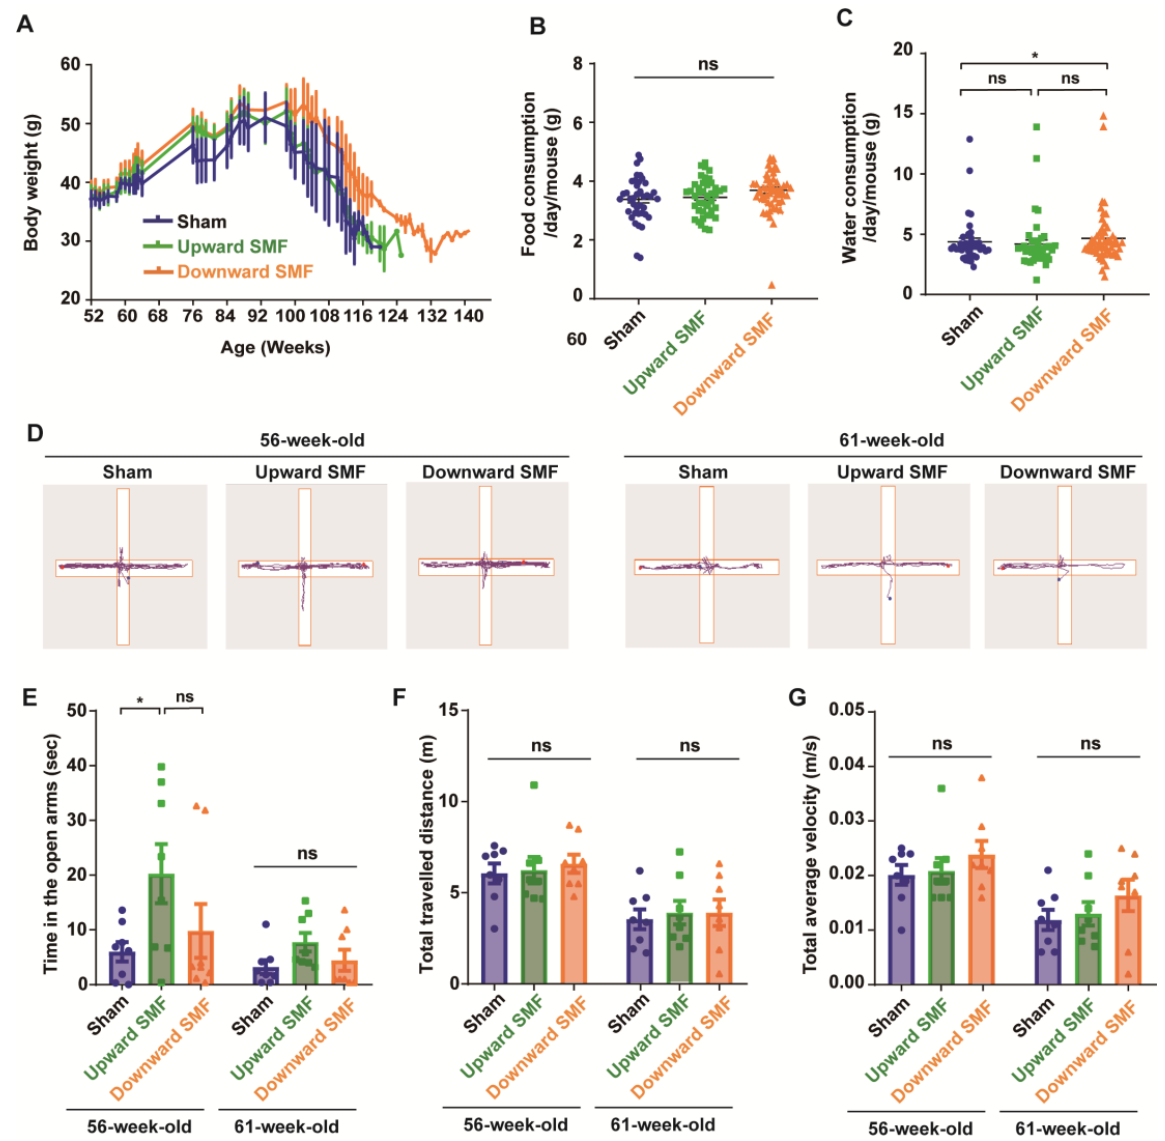
Figure 2. Elevated plus maze test shows that SMFs could improve the exploration activity of aged mice. ( A ) The mice body weight changes; ( B ) food consumption; ( C ) water consumption; ( D ) representative trajectories of mice in elevated plus maze test at 56 and 61 weeks old, respectively. The blue and red points show start and end points, respectively; ( E ) time in the open arms; ( F ) total traveled distance; ( G ) total average velocity. n=8 mice for the sham, upward SMF or downward SMF group in the beginning of the experiment. Values were expressed as means ± SEM. * p < 0.05 by Student’s t -test. ns, no significance.